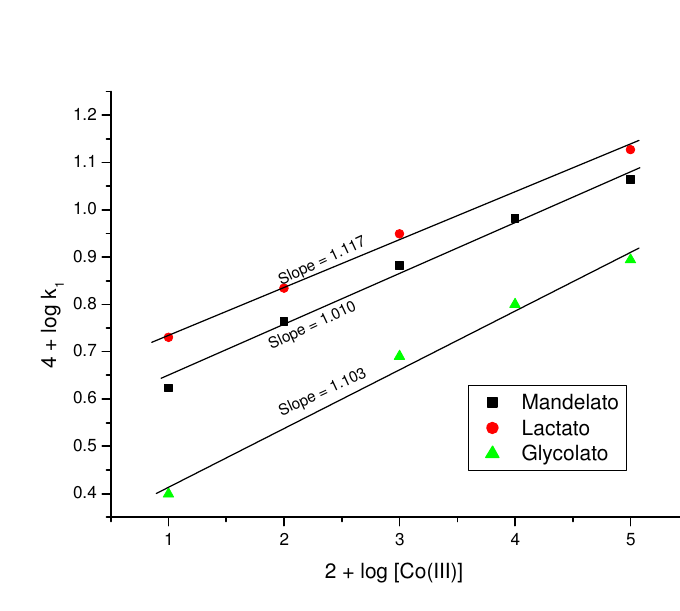
Figure 2. Dependence of rate on [Co(III)] in NaLS